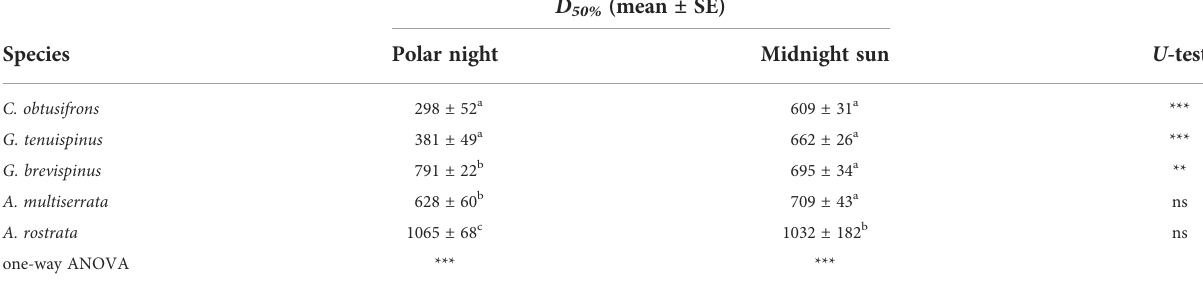
TABLE 2 Summary of vertical distribution (vertical distribution core: D 50% , mean ± SE) of fi ve Aetideidae copepods in the western Arctic Ocean during the polar night and midnight